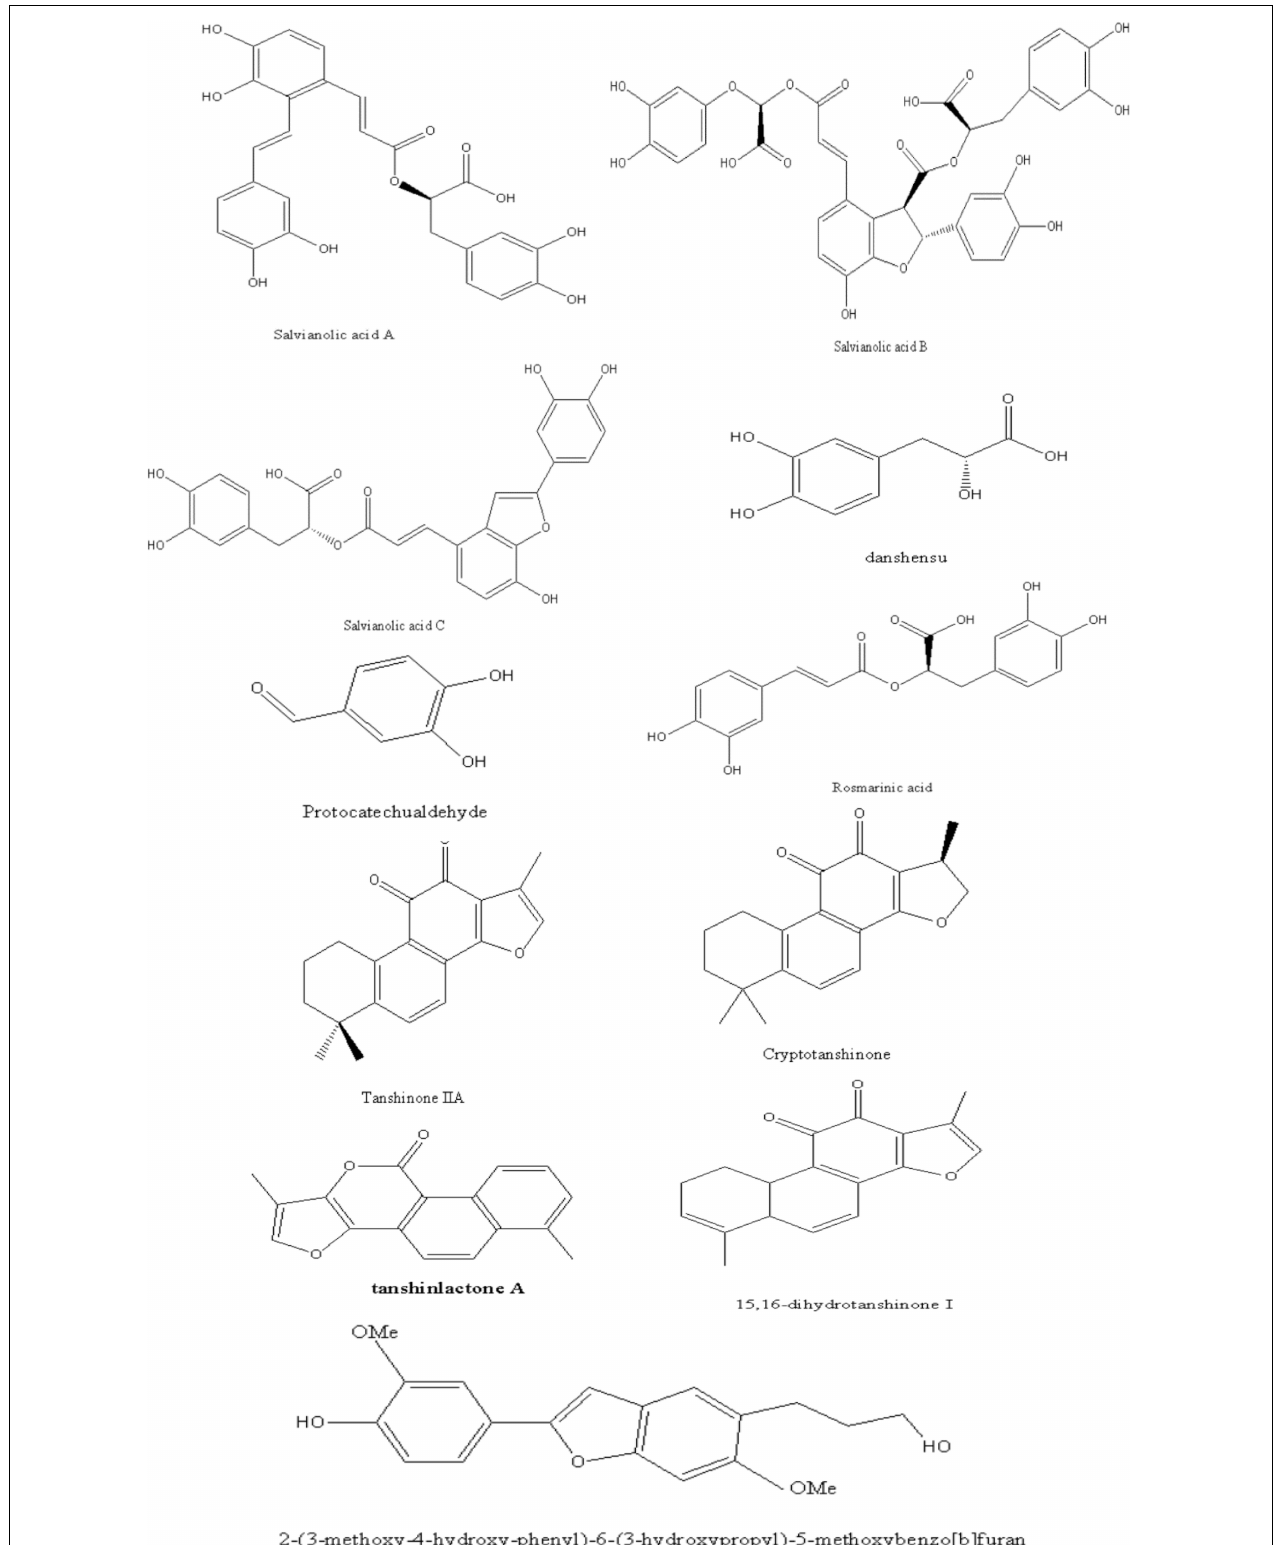
FIGURE 1 | The compounds in Danshen related to the pharmacological effects of NAFLD.